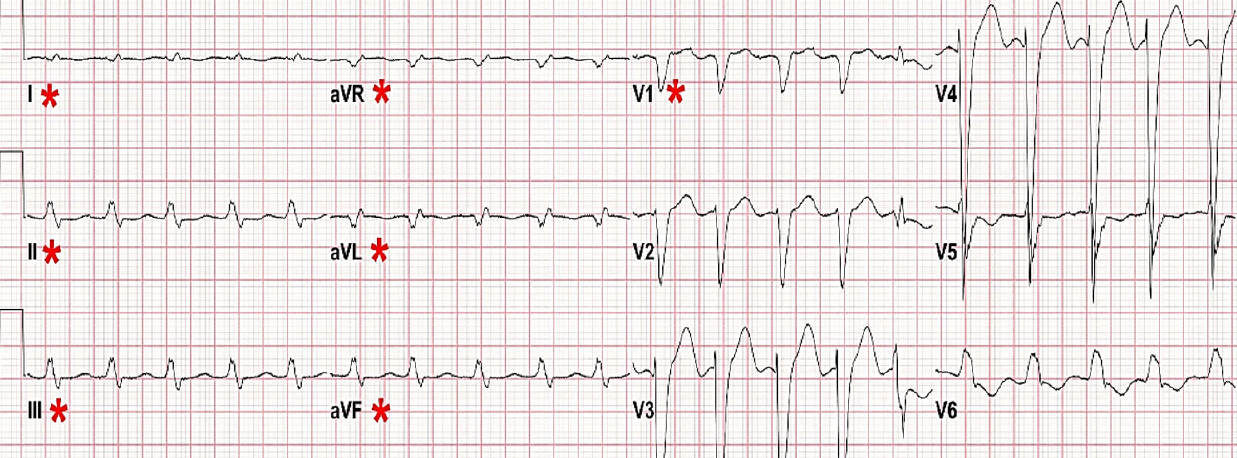
Figure 4. Low amplitude QRS complexes in the limb leads in a patient with left bundle branch block. The * (red) denotes